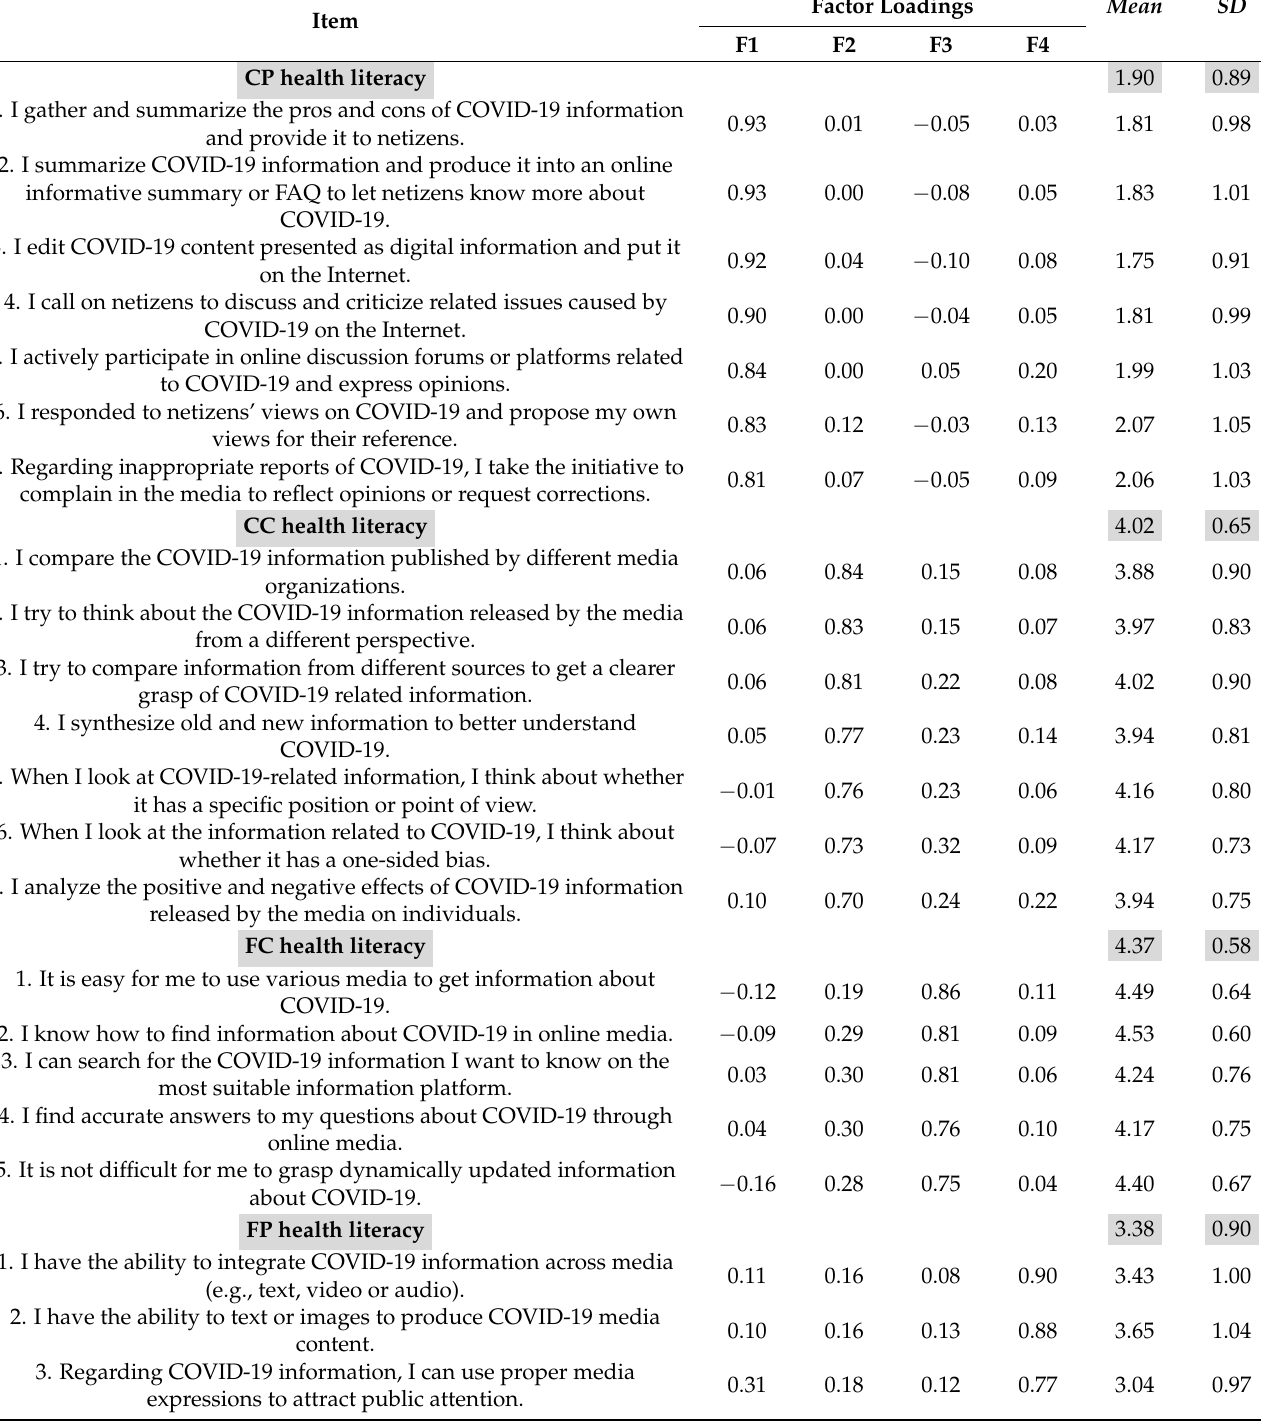
Factor Loadings